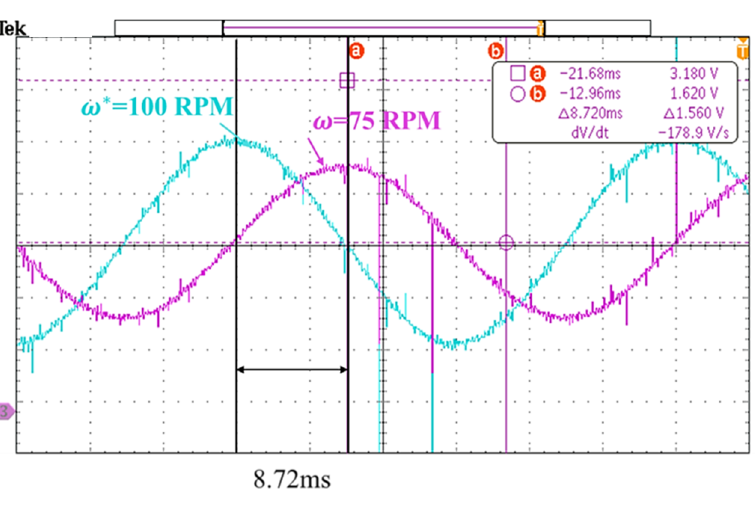
Figure 14. Speed loop frequency response verification.